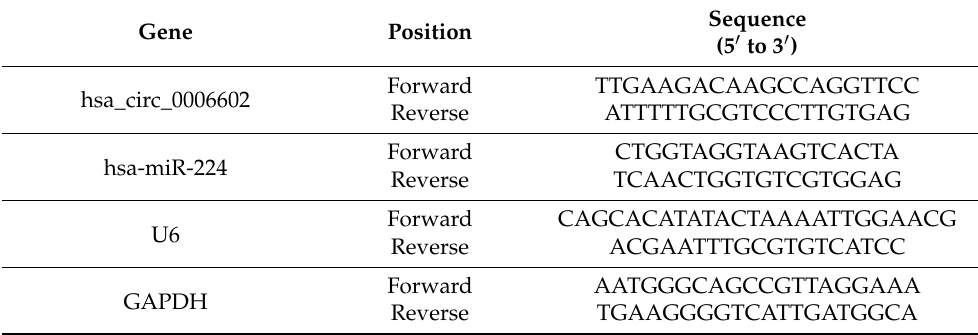
Table 2. The sequences of the